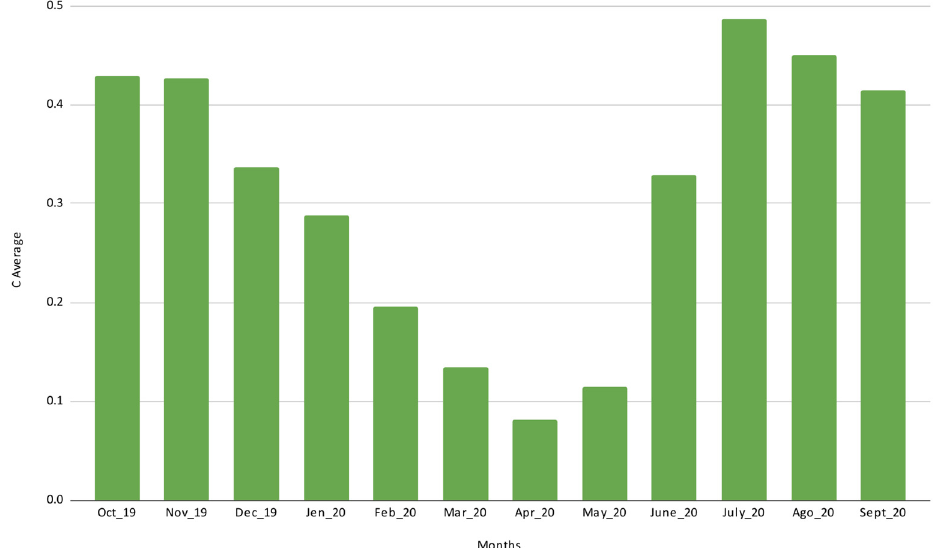
Figure 4. Histogram of the C values trend during the months of analysis (from October 2019